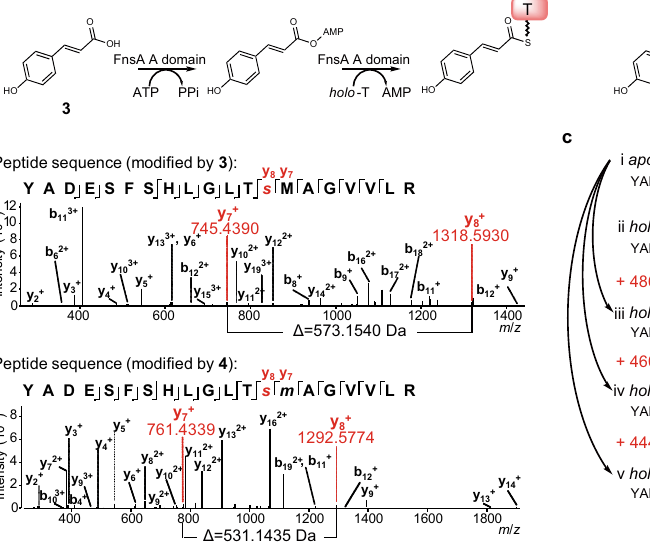
produced by collision-induced fragmentation at the peptide bond in the mass spectrometer.Thesubscriptednumber(e.g.,y 7 ,y 8 )representsthenumberof N -or C -terminal residues present in the peptide fragment. The mass of Serine residue is 87.0320Da. Compared to apo -target peptide, Ser607 modi fi ed by 3 is with a the- oretical mass shift of +486.1226Da and Ser607 modi fi ed by 4 is with theoretical mass shifts of +460.1070Da and +444.1120Da when Met608 is